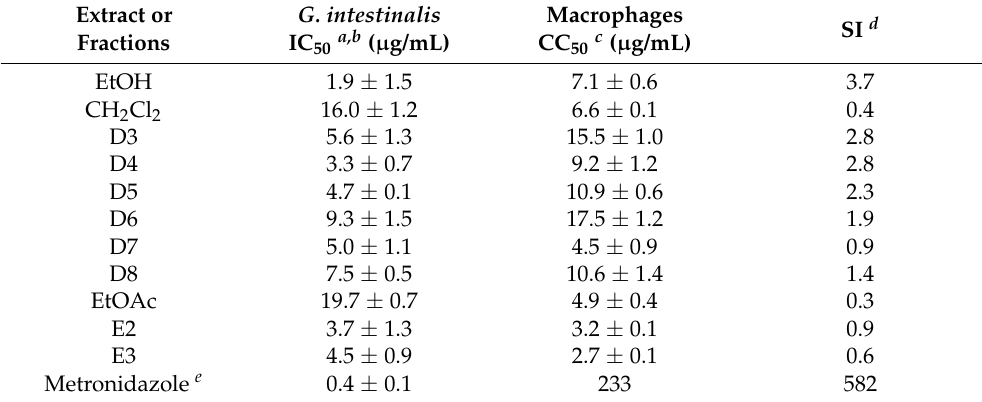
Metronidazole e 0.4 ± 0.1 233 582 a IC 50 : concentration able to inhibit 50% of trophozoites. b Fractions and sub-fractions not included were inactive, IC 50 > 20 µM. c CC 50 concentration able to inhibit 50% of murine macrophages. d SI: selectivity index (CC 50 /IC 50 ). e Metronidazole was used as a positive control.